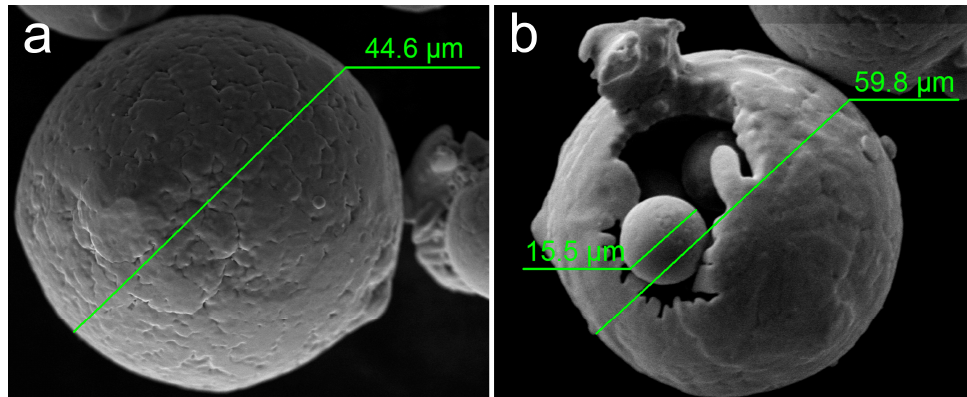
Figure 1. SEM image of typical morphology of virgin ( a ) and recycled ( b ) powder.